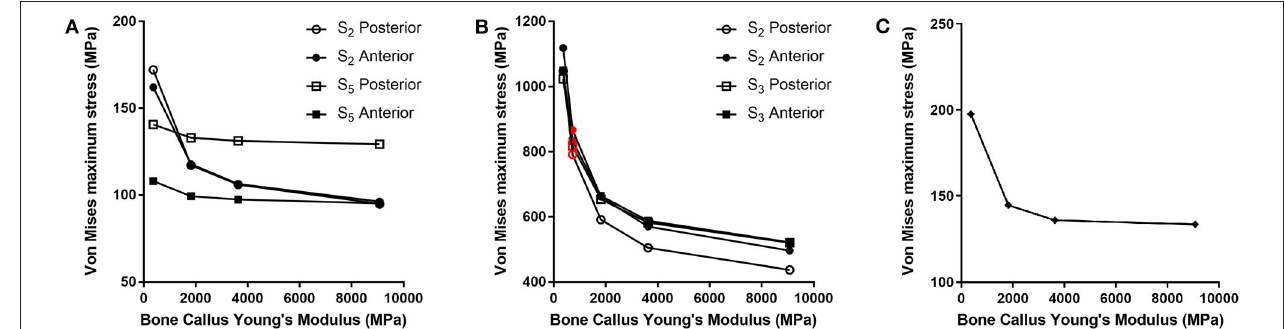
FIGURE 9 | Von Mises maximum stresses (MPa) varying the bone callus Young’s modulus resulting from (A) the walking load condition in the S2 and S5 zones (posterior and anterior areas); (B) the stumbling load condition, in the S2 and S3 zones (posterior and anterior areas). Results regarding a bone callus Young’s modulus equal to 726.4 MPa are highlighted in red. (C) The lateral falling load condition.